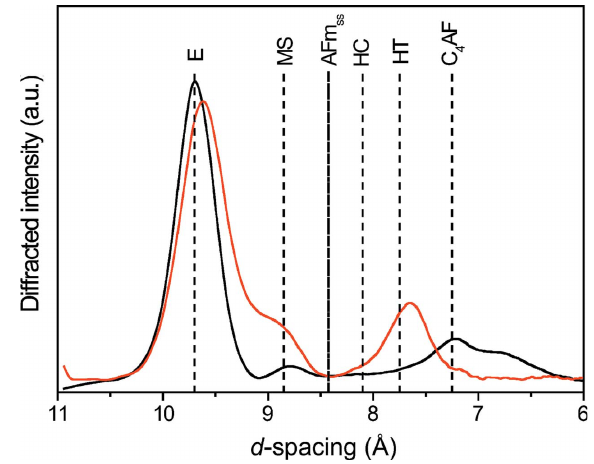
Figure 3 XRD patterns of blast furnace cement after 24 h of hydration (black) and six months of curing (red). E, MS, AFm ss , HC, HT and C 4 AF are ettringite, monosulfate, solid solution of hemicarbonate and OH (cid:6) substituted monosulfate, hemicarbonate, hydrotalcite and ferrite, respec- tively, as determined by previous studies (Matschei et al. , 2007; Scho¨ler et al. , 2015)